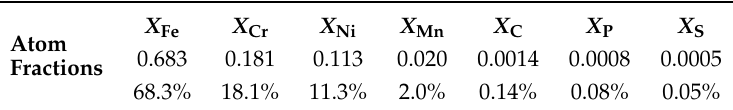
Figure 1. Sketch of a AISI316L tube-fitting nut (Swagelok R (cid:13) ). The colored cross section exhibits the simulated maximum principal stress distribution under service conditions (in MPa), obtained by finite-element analysis. Table 1. Composition of AISI316L stainless steel